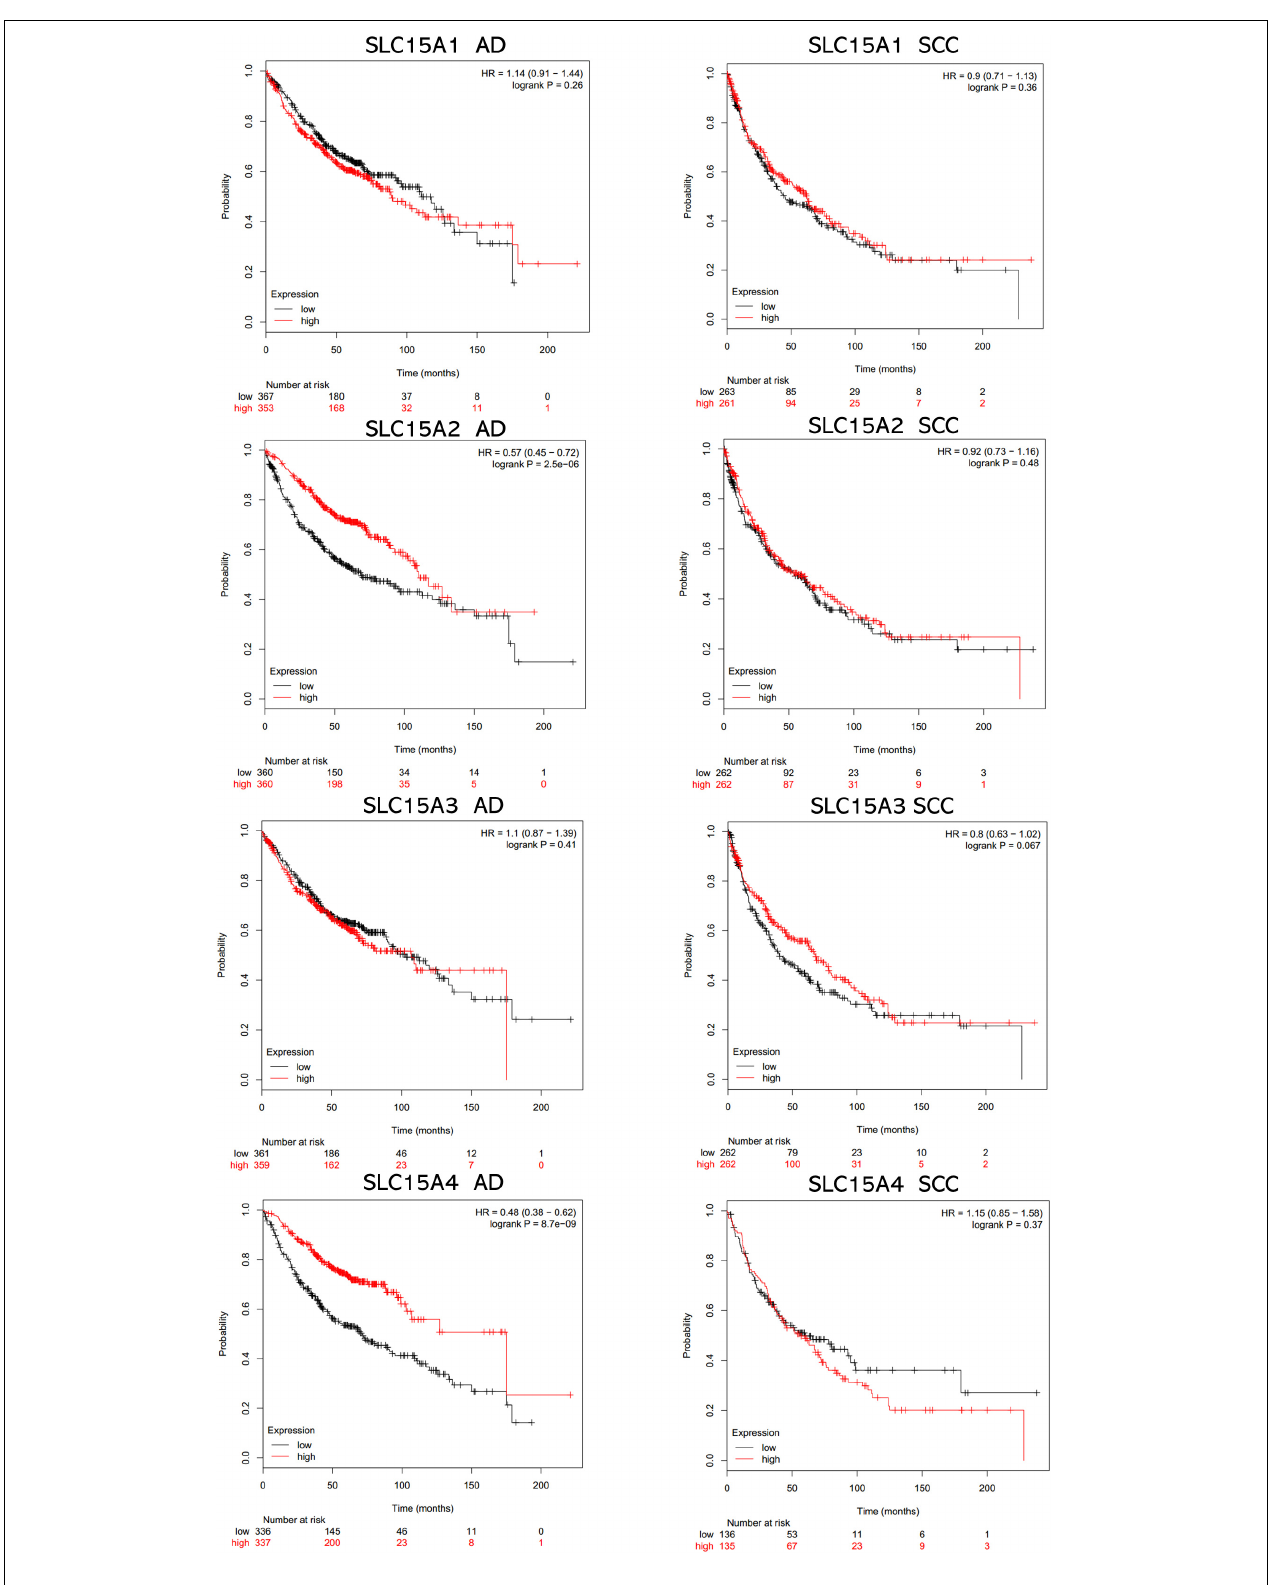
FIGURE 4 | The prognostic values of SLC15A family members in lung cancer major subtypes (AD, adenocarcinoma; SCC, squamous cell carcinoma). The median expression level was set as the cutoff for the KM plot. The red line indicates high expression, and the blue line indicates low expression.